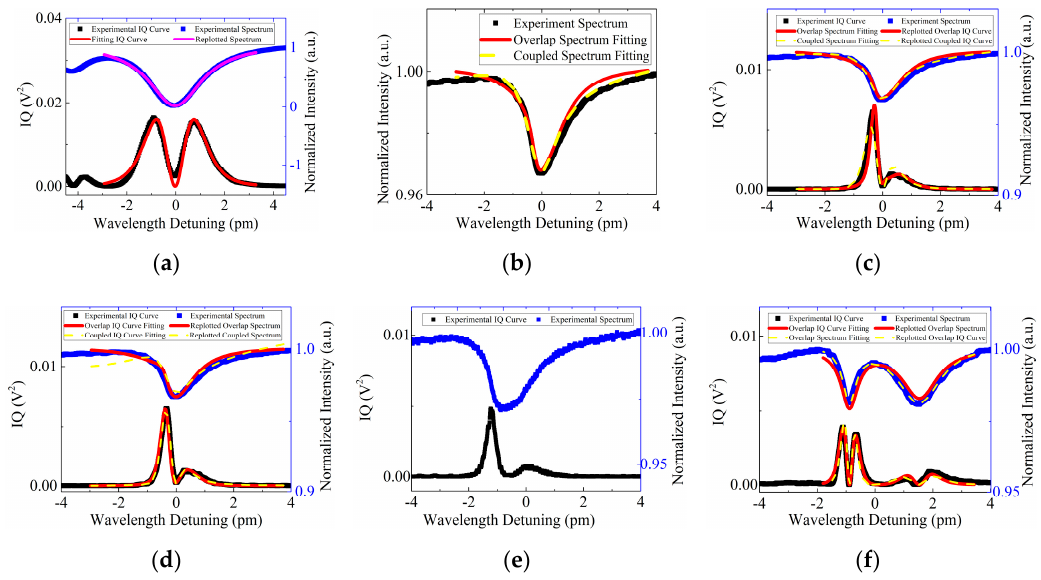
Figure 2. ( a ) Standard single resonance transmitted spectrum (blue scattered line), its IQ curve (black scattered line), fitted IQ curve (red solid line) and replotted resonance (magenta solid line). ( b ) Experimental (black scattered line) and fitted (red solid line ( g = 0), yellow dashed line (g = 1.19 × 10 4 MHz)) spectrum at inner pressure of 0.387 bar. ( c ) Experimental spectrum (blue scattered line) and IQ curve (black scattered line), fitted resonances, and replotted IQ curves (red solid line ( g = 0 MHz) and yellow dashed line ( g = 1.19 × 10 4 MHz)). ( d ) Experimental spectrum (blue scattered line) and IQ curve (black scattered line), fitted IQ curves and replotted resonances (red solid line ( g = 0 MHz), and yellow dashed line ( g = 3.76 × 10 3 MHz)). ( e ) and ( f ) Experimental resonances (blue scattered line) and IQ curve (black scattered line) at inner pressure of 0.411 bar and 0.579 bar, respectively, fitted and replotted curves (red solid line and yellow dashed line). Table 1. Overlapping resonances fitting results.